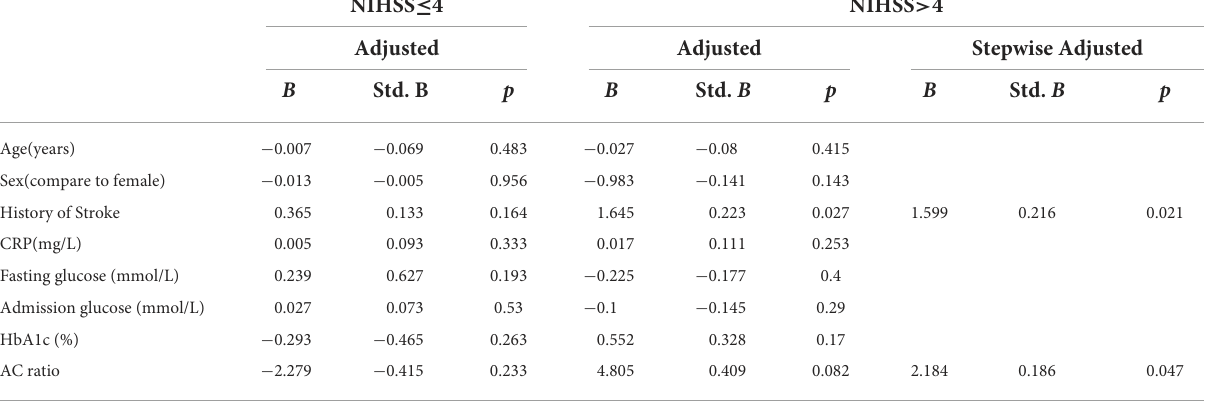
TABLE 3 Regression analysis of admission NIHSS at different levels.